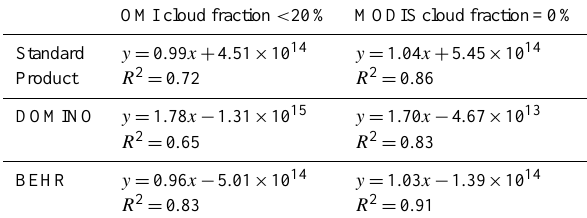
Table 3. Equation for the best fit line and correlation coefficient for satellite columns versus in situ columns when the OMI cloud fraction and MODIS cloud fraction thresholds are used.